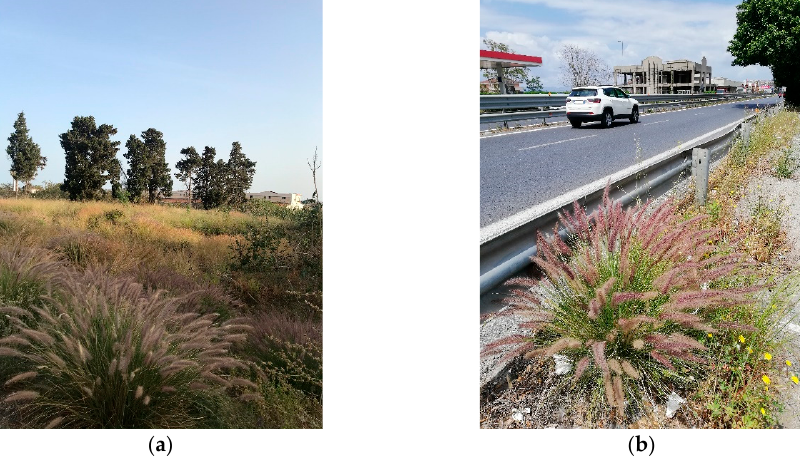
Figure A4. Juvenile of Casuarina equisetifolia L. on a wall in the city of Reggio Calabria.